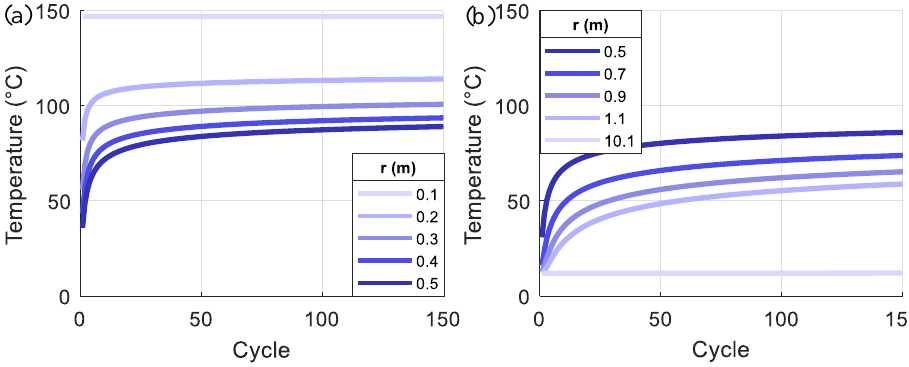
Figure 11. Maximum temperature of each loading cycle in the: ( a ) concrete; ( b ) soil.